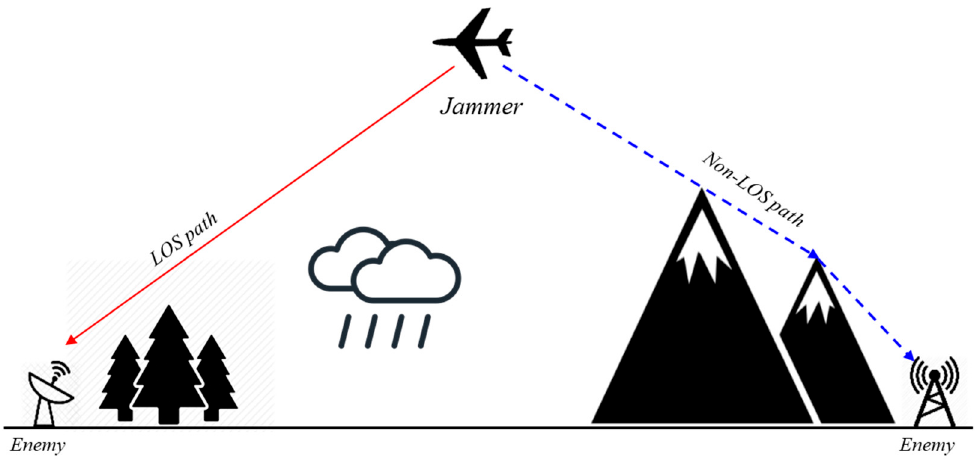
Figure 1. Electronic warfare scenario.